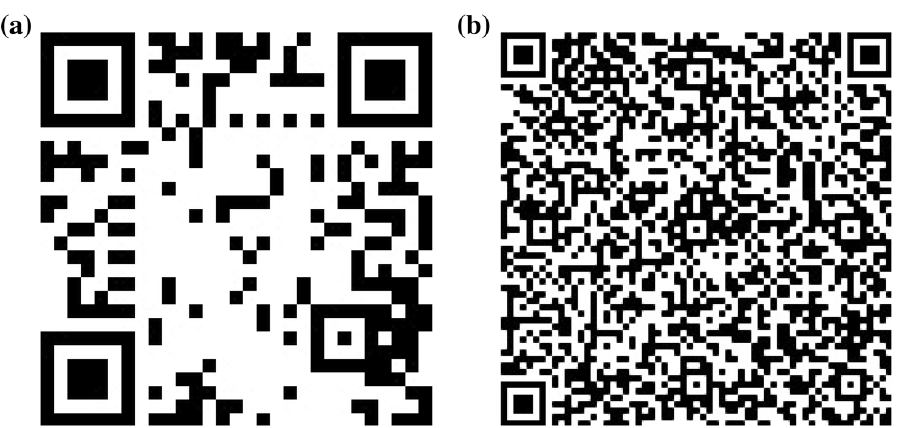
Figure 1. QR codes used during the trial: Version 3 (V3) with 29 modules ( a ); Version 11 (V11) with 61 modules ( b